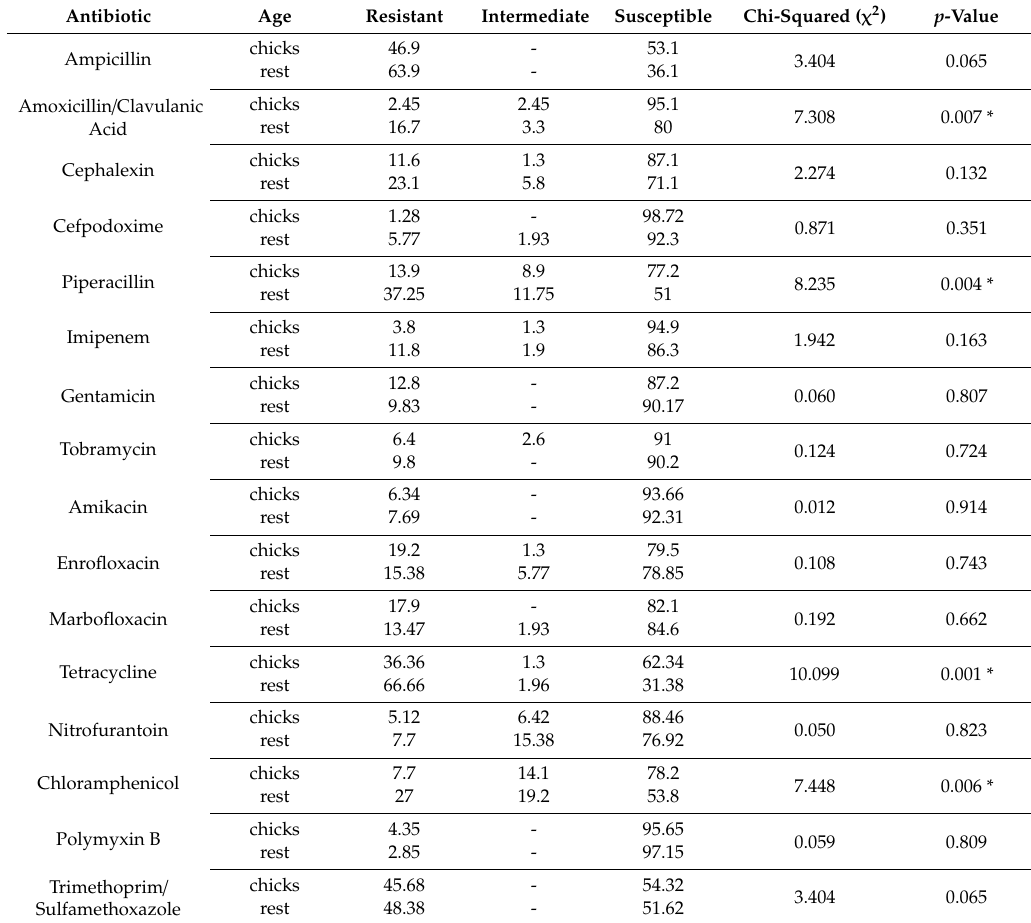
Table 3. Susceptibility of bacteria isolated from chicks in the nests and from the rest of animals (adult and immature birds). Results of the statistical di ff erences between chicks and the rest of the animals are presented.